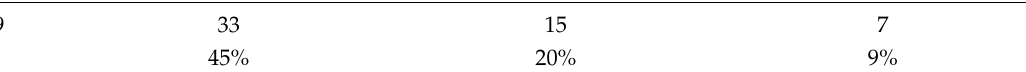
Cumulative drought stress response index (CDSRI) values were further used to com- pute the correlations between the shoot, root, and physiological traits with the cumulative drought stress response index (Figure 5). An overall linear positive correlation was ob- served between the CDSRI and total shoot traits (R 2 = 0.36), root traits (R 2 = 0.81), and physiological parameters (R 2 = 0.10). A similar strong linear correlation was also observed between the CDSRI and root traits (R 2 = 0.81) (Figure